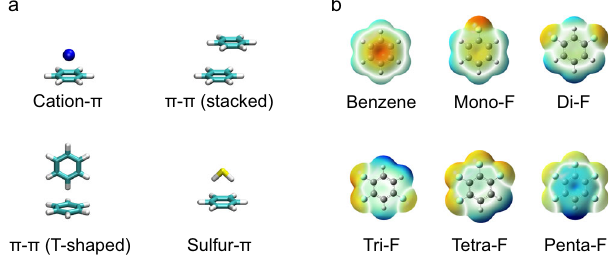
Fig. 1 | Depictions of geometry and electrostatics. a Illustrations of types of π interactions in which phenylalanine can participate. b Electrostatic views of ben- zene(asastructuralsurrogateforphenylalanine)and fl uorinatedanalogs.Coloring is to the convention of Red=negative, Blue=positive.